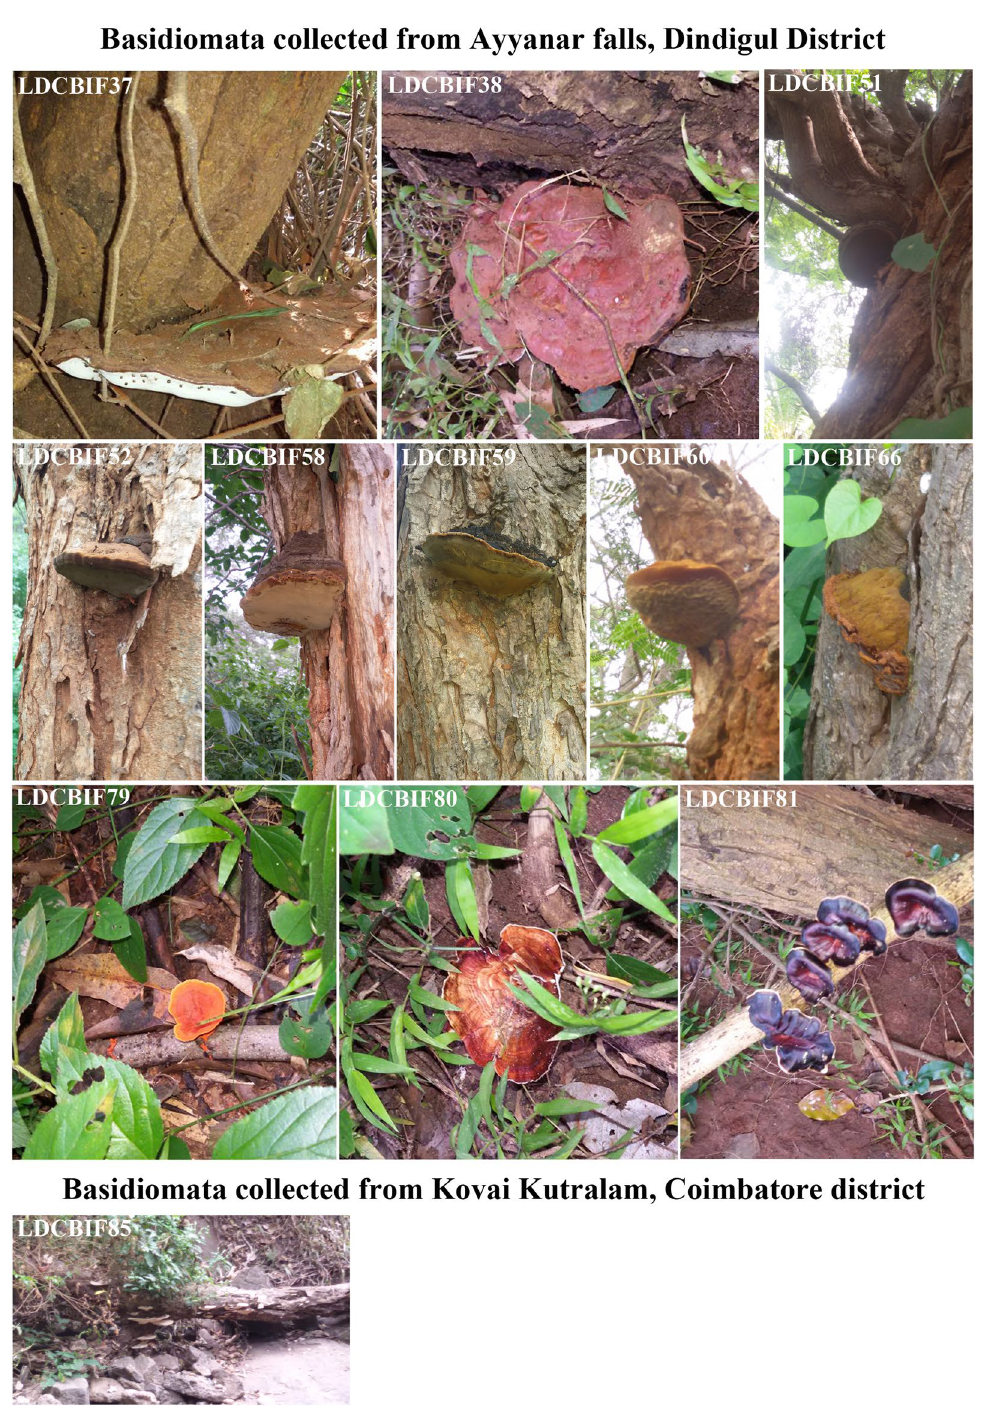
Figure 4. Field photographs of Basidiomata collected from Ayyanar Falls, Dindigul and Kovai kutralam, Coimbatore District. The macrofungi grown on the host species: Ayyanar Falls - Albizzia sp., - LDCBIF51, LDCBIF52, LDCBIF58, LDCBIF59, LDCBIF60, LDCBIF66. Few isolates were collected from the decayed matter (LDCBIF79 - LDCBIF81) and wood log (LDCBIF37 & LDCBIF38). Kovai Kutralam - wood